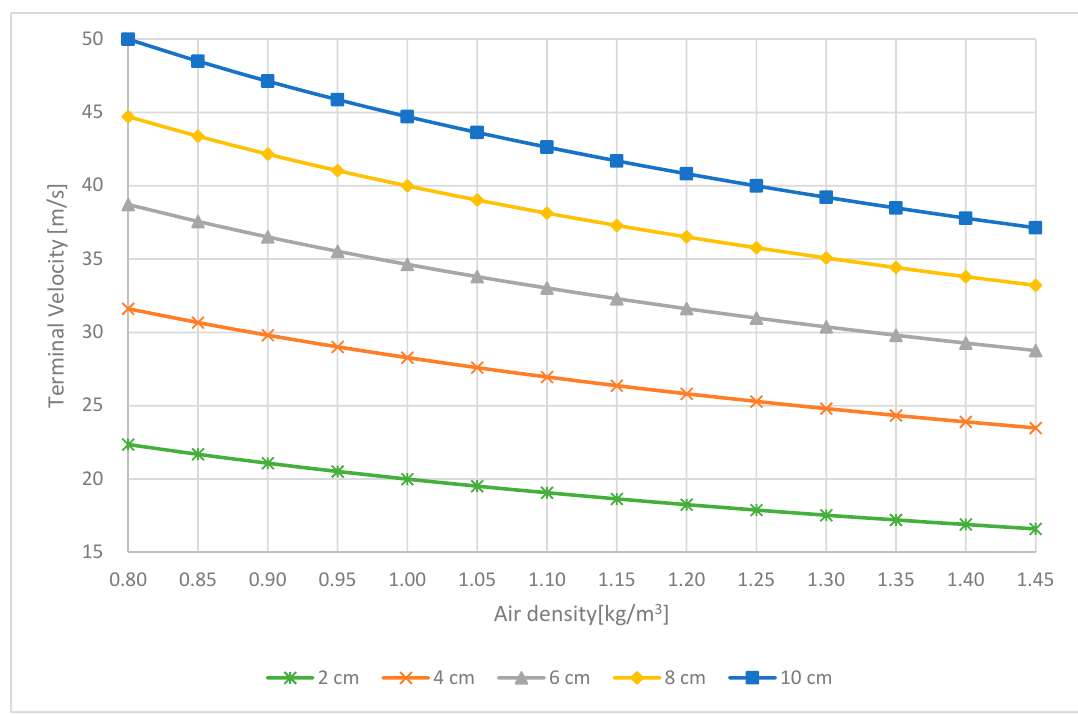
Figure 2. Terminal velocity of different sized hailstones (diameter in cm) at varying air densities.